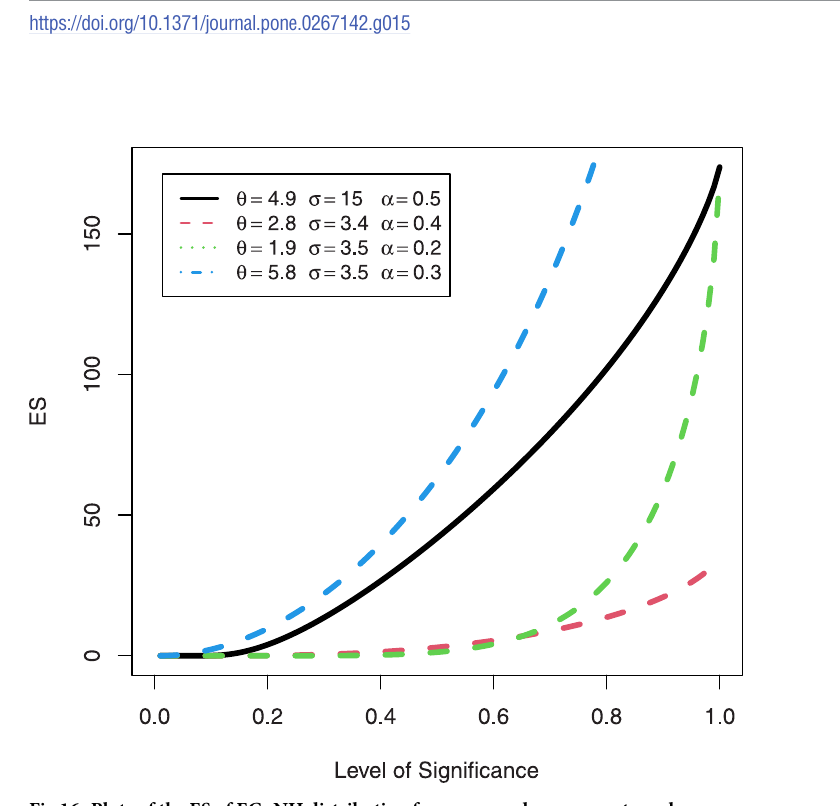
Fig 16. Plots of the ES of EGuNH distribution for some random parameter values.